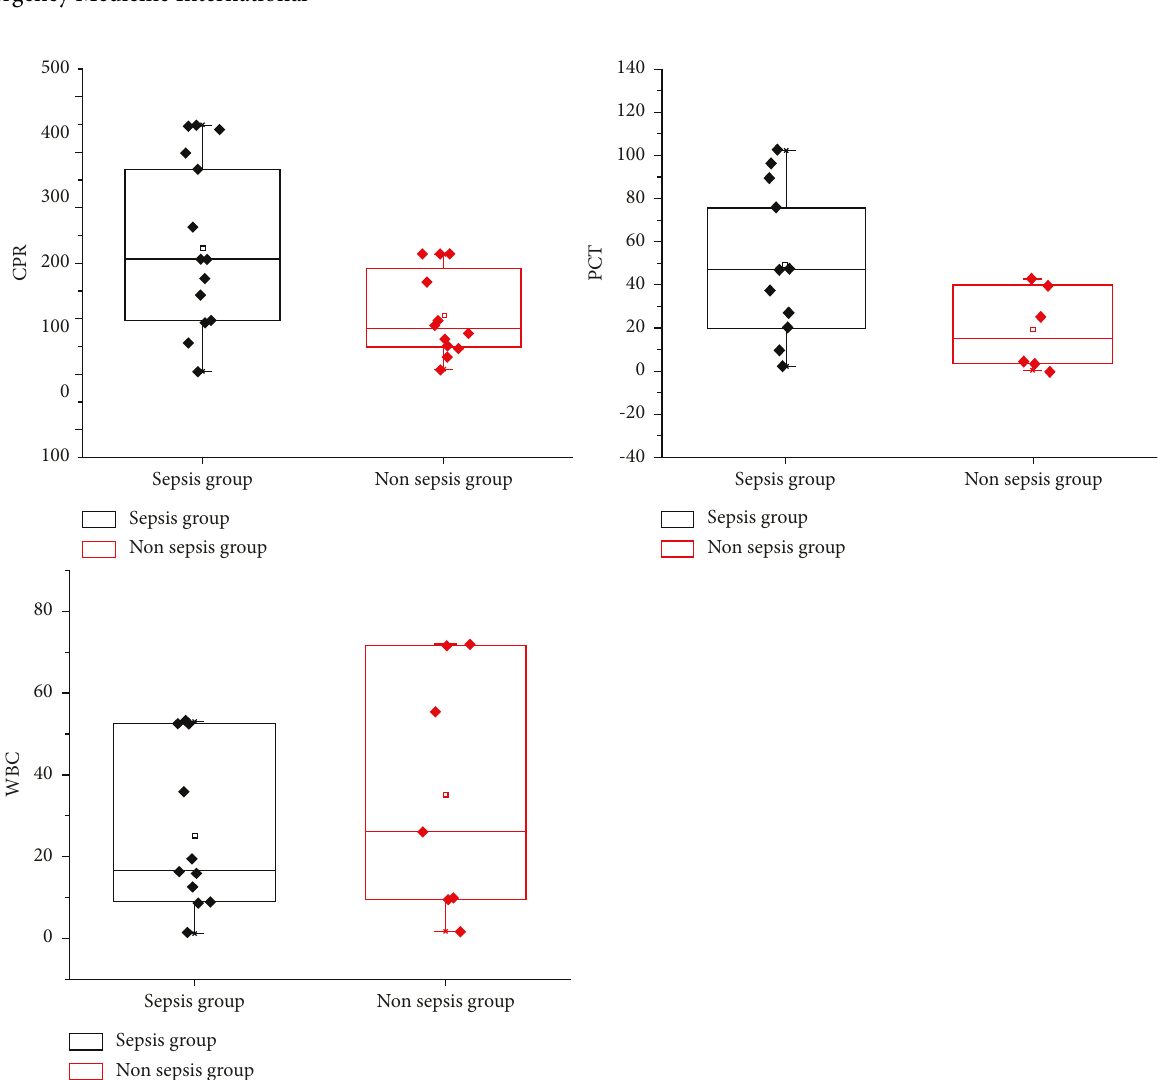
Figure 2: Comparison of CRP, PCT, and WBC levels between blood culture-positive sepsis and non-sepsis. Note: CRP: C-reactive protein; PCT: procalcitonin; WBC: white blood cell count; ∗∗∗ : P < 0 . 001. CRP, PCTand WBC levels were compared using Wilcoxon rank sum test for two independent